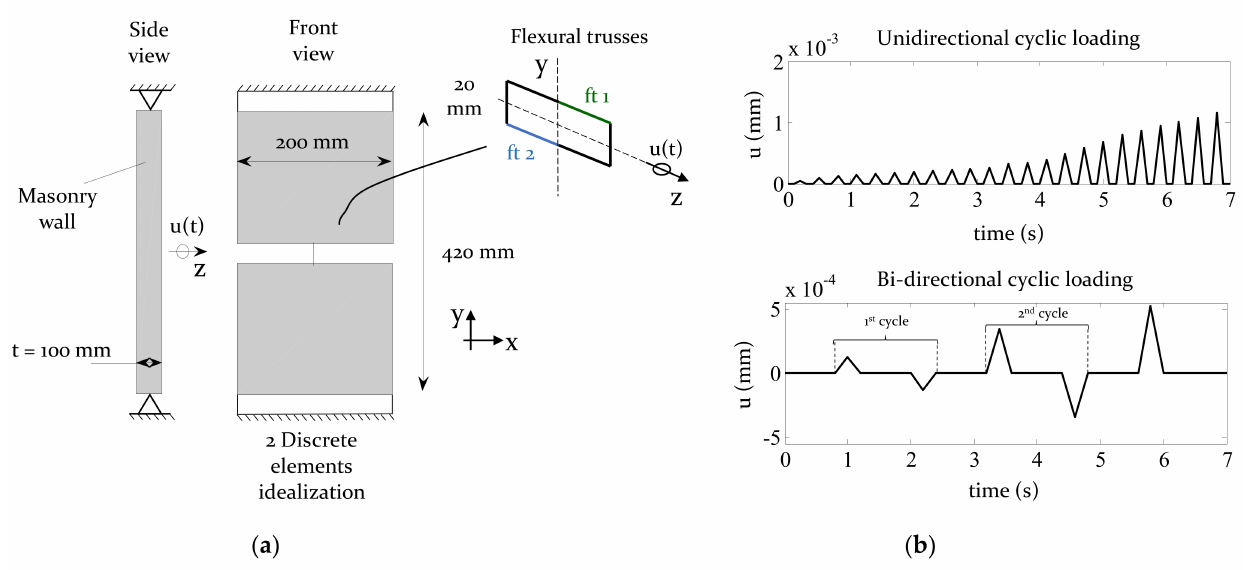
Figure 7. Nonlinear validation of the macro–constitutive model for an out–of–plane loaded wall.